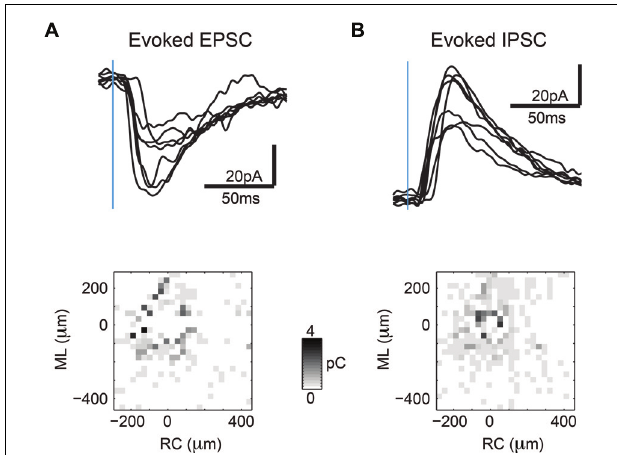
FIGURE 3 | Sample synaptic current traces from area photostimulated further from the soma show patchy connectivity. (A) Sample inward currents ( > 8 ms latency) are EPSCs indicating excitatory synaptic connectivity (top). Map of inward current charges shown at different photostimulation locations shows patchiness of excitatory inputs at locations further away from soma (bottom). (B) Sample outward currents ( > 8 ms latency) are IPSCs indicating inhibitory synaptic connectivity (top). Map of outward current charges shown at different photostimulation locations show rounder extent of inhibitory inputs but are also patchy at locations further away from soma